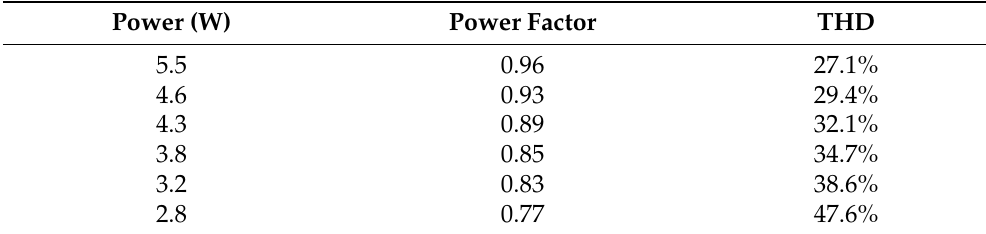
Table 4. Power consumption, power factor, and THD obtained from the ACU-LUM when connected to the luminaire.